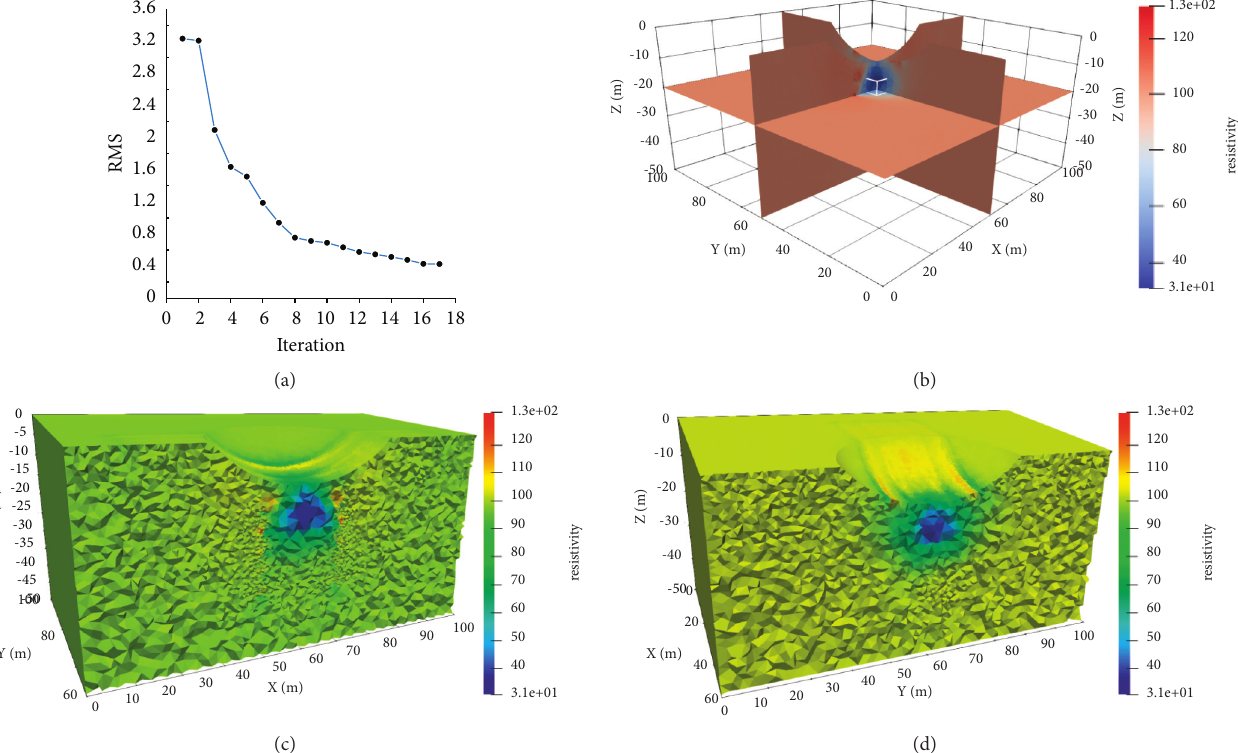
Figure 11: Inversion results of anomalous bodies under valley topographical model. (a) The relative fitting error RMS during the inversion process; (b) slice of resistivity 3D inversion result; (c) slice of resistivity inversion result at XOZ profile; (d) slice of resistivity inversion result at YOZ profile. The outline of the true model is indicated by the white